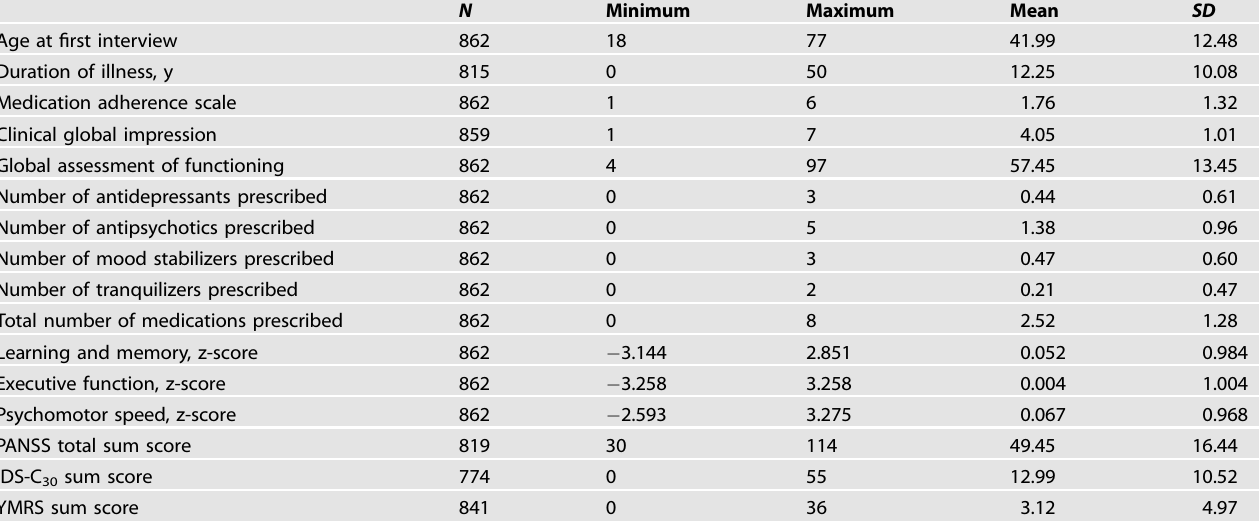
Table 1. Descriptive data of the